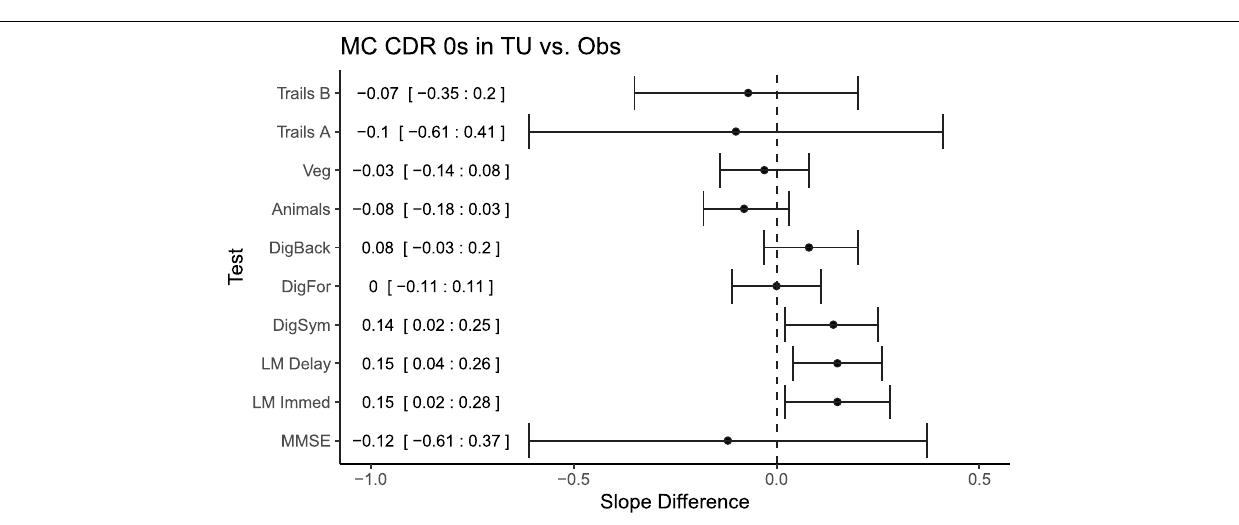
FIGURE 5 | Differences in slopes (and 95% CIs) for each test between CDR 0 mutation carriers in TU vs. the Obs study. A positive slope difference indicates a larger or more positive slope (improvement) in the TU compared to the Obs study. Some tests, such as Logical Memory and Digit Symbol, had more improvement or practice effects in the TU vs. Obs. Mean differences and 95% CIs presented along the left side of the